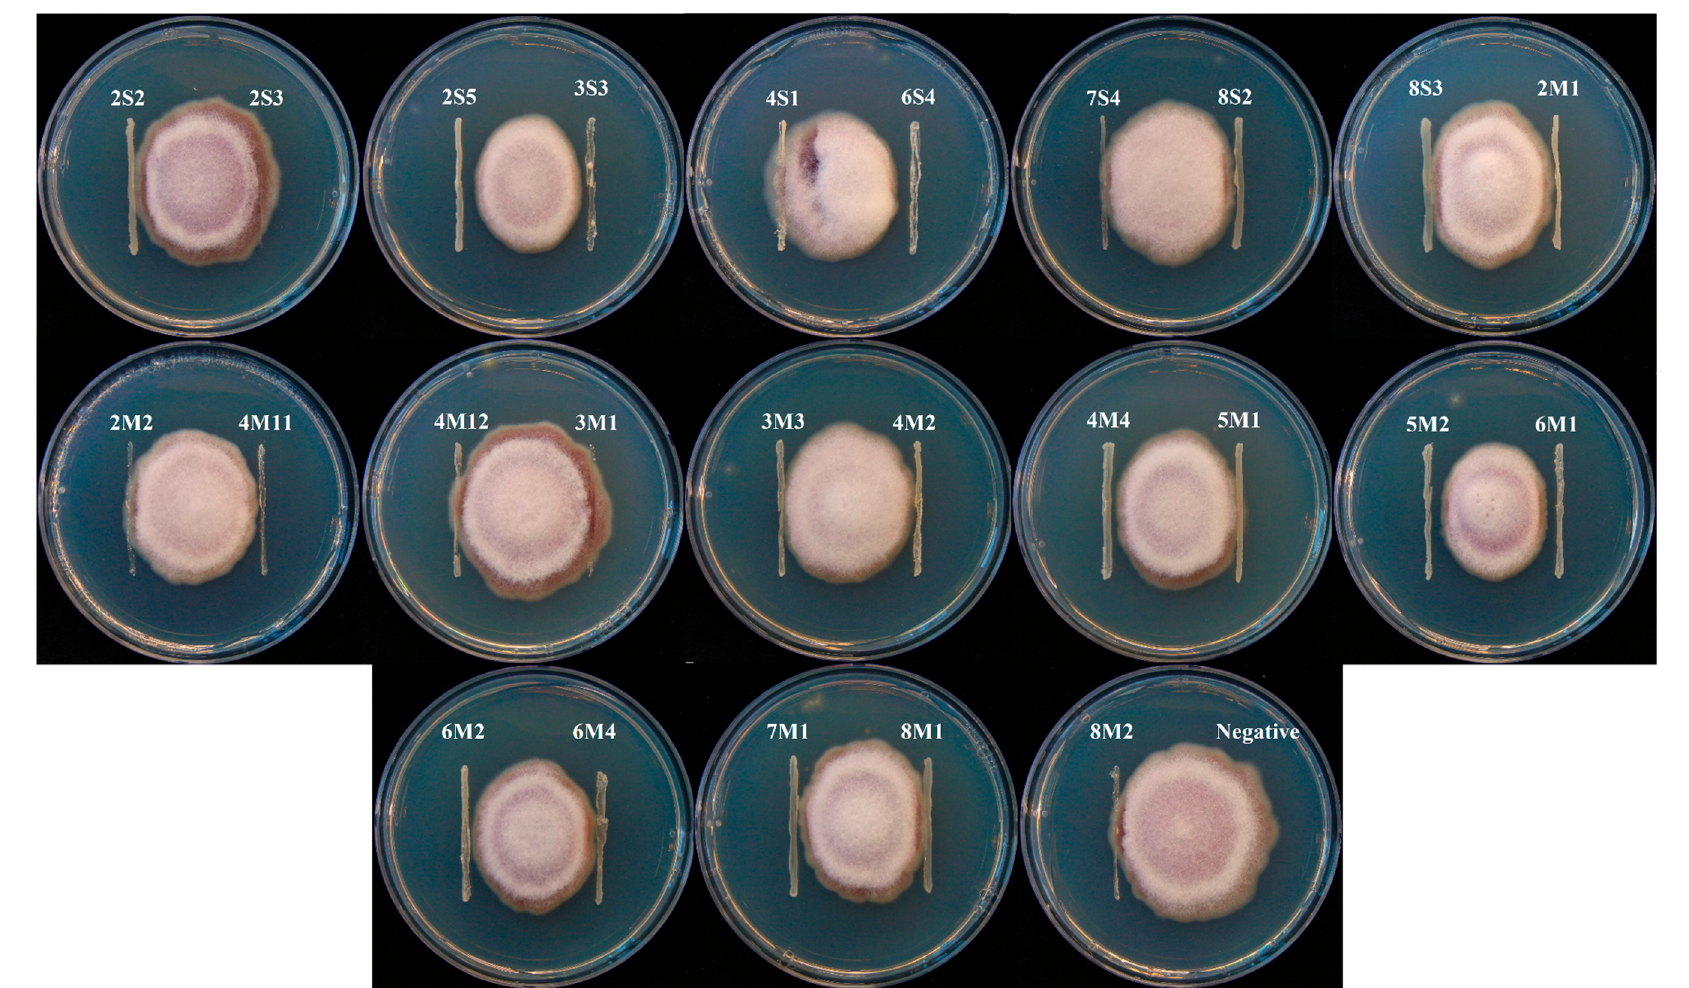
Figure 1. Plate assays of lactic acid bacteria (LAB) isolates against F. graminearum after 8 d of incubation .